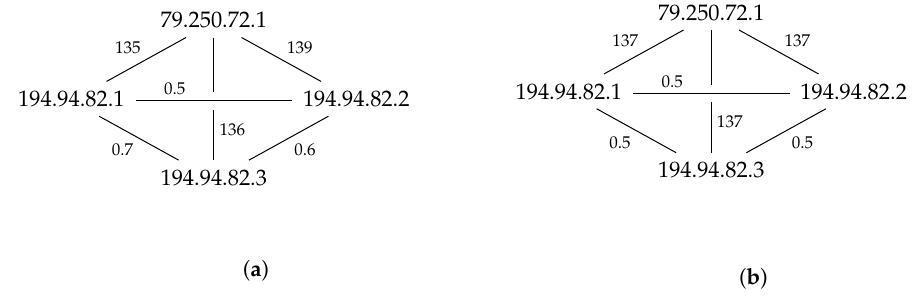
Figure 3. (a) Measured latency; (b) Latency approximated by